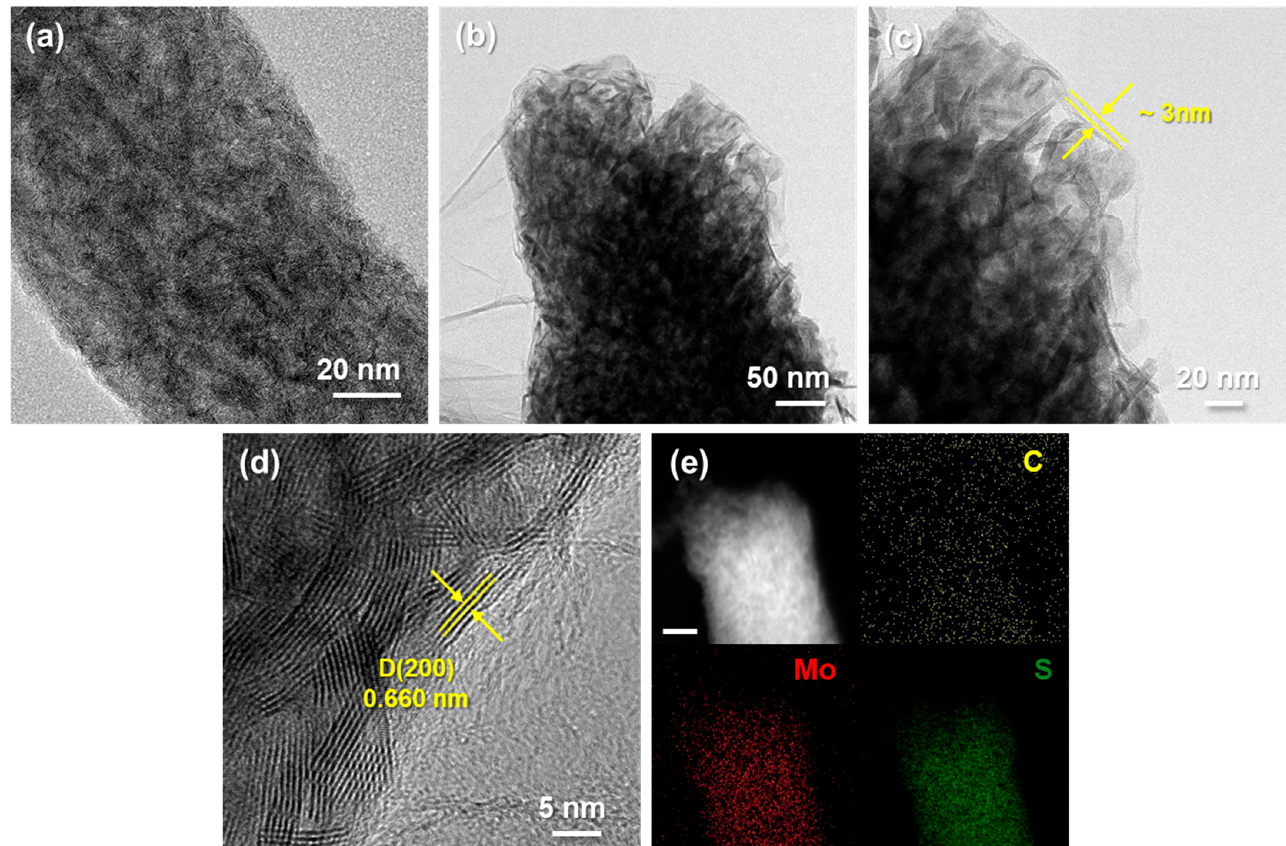
Figure 3. TEM images of ( a ) MoS 2 @CNFs and ( b ) MoS 2 @CNFs@rGO, ( c , d ) HR-TEM images of MoS 2 @CNFs@rGO, ( e ) STEM image and elemental distribution of C, Mo, and S in the MoS 2 @CNFs@rGO (scale bar: 20 nm).